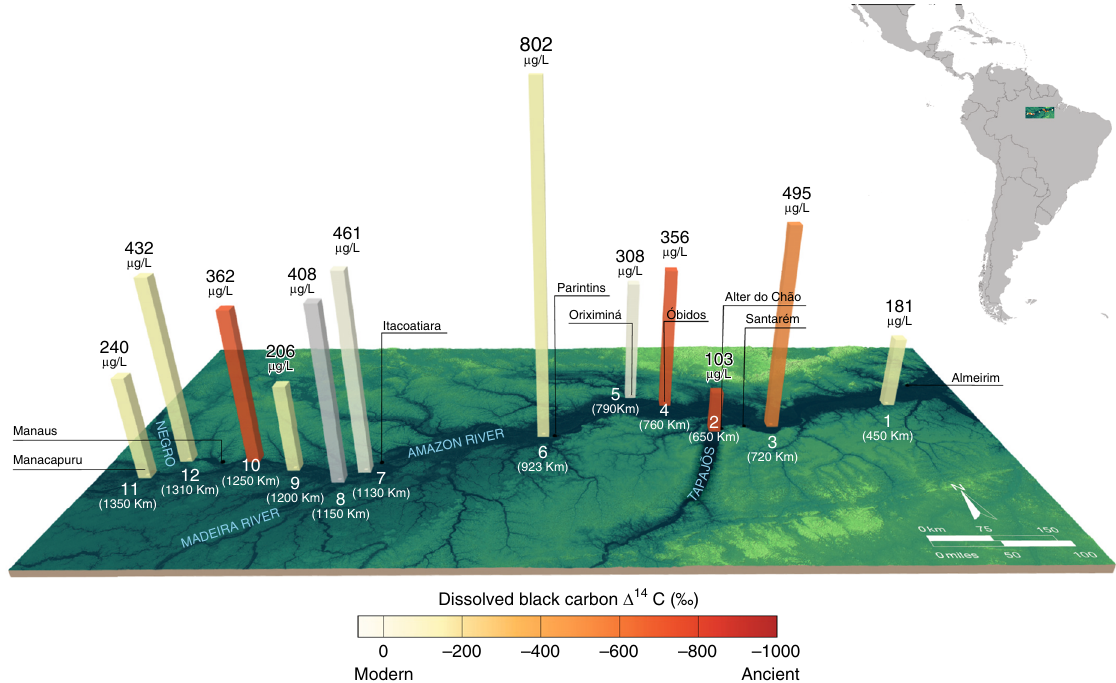
Fig. 1 Dissolved black carbon concentration and radiocarbon values. Sample locations plotted as distance to the river mouth (in km, in white text) with the river (in blue text) and nearest city (black text). Dissolved black carbon (DBC) concentrations are shown by the height of the columns in μ g DBC L − 1 . The shades of yellow to red of columns represents modern to ancient DBC Δ 14 C values. Station locations (in white) are labeled 1 – 12 according to Supplementary Fig. 1. The gray column at station 8 indicates no DBC Δ 14 C data. Error bars (s.d) are given in Supplementary Table